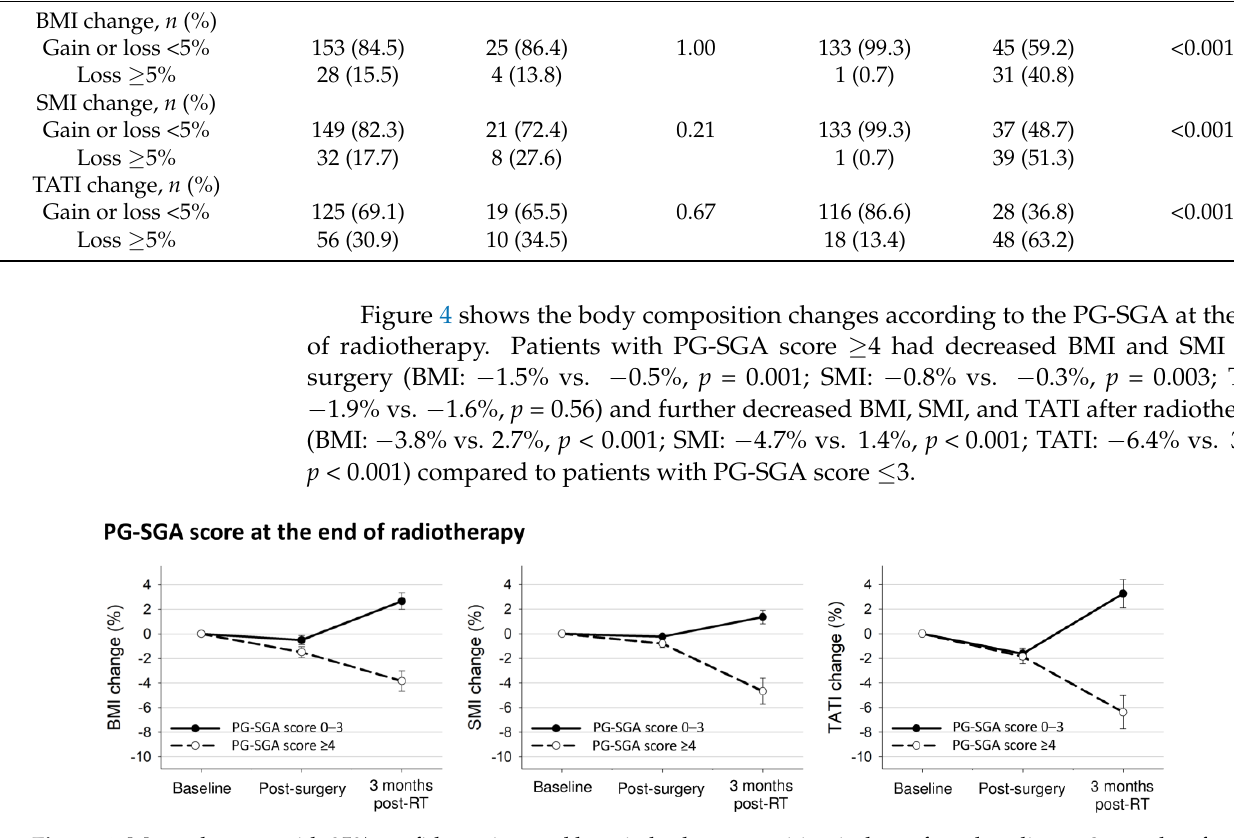
Figure 4. Mean changes with 95% confidence interval bars in body composition indexes from baseline to 3 months after treatment completion according to PG-SGA at the end of radiotherapy.